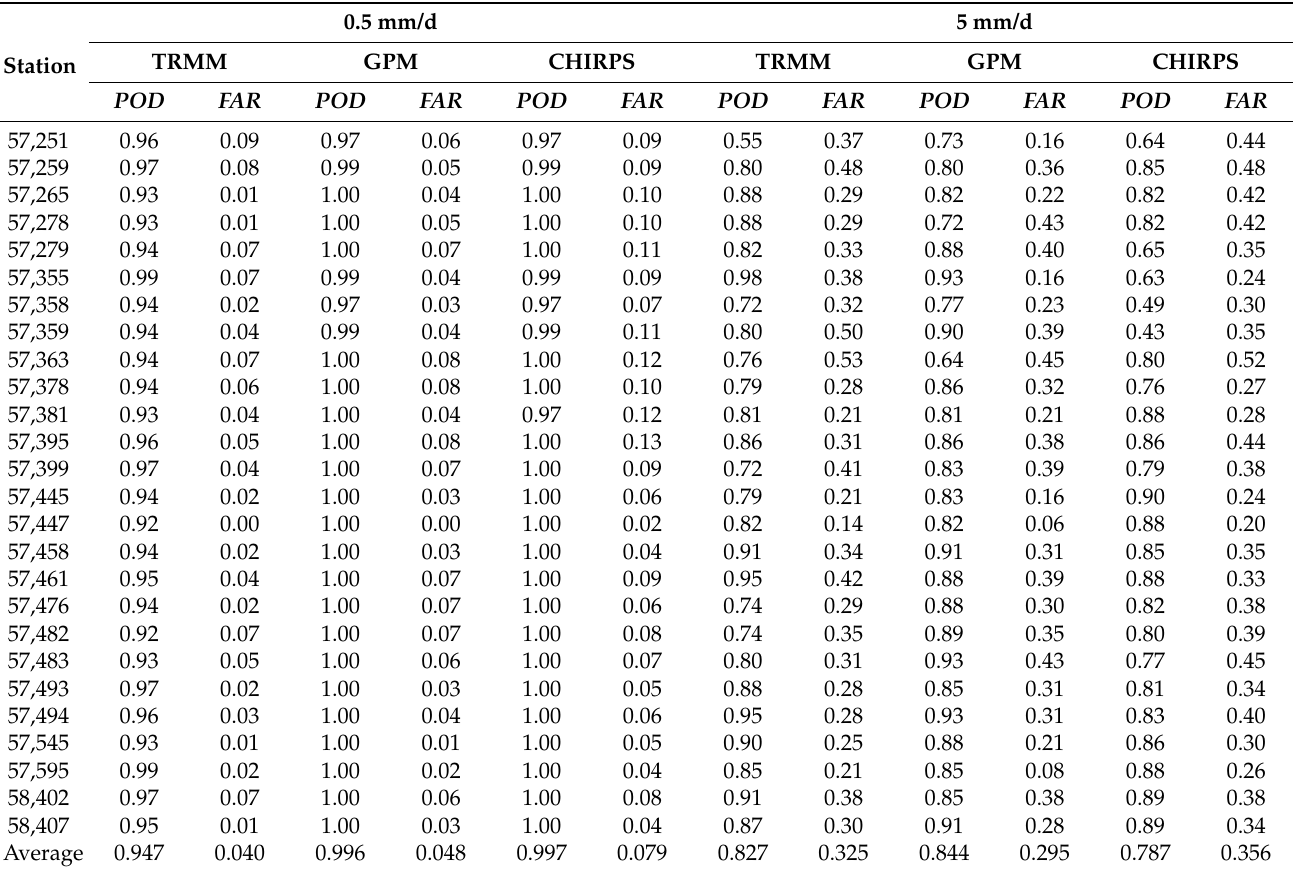
Table 3. The POD and FAR values of TRMM, CHIRPS, and GPM at 0.5 mm/d and 5 mm/d precipita- tion thresholds based on 26 meteorological